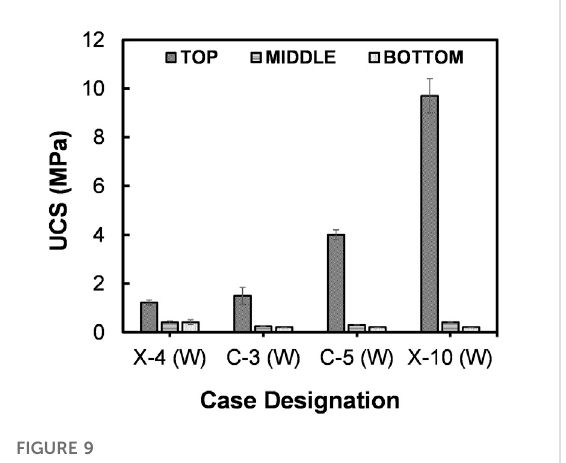
FIGURE 9 Comparison of UCS between the cases treated under low temperature